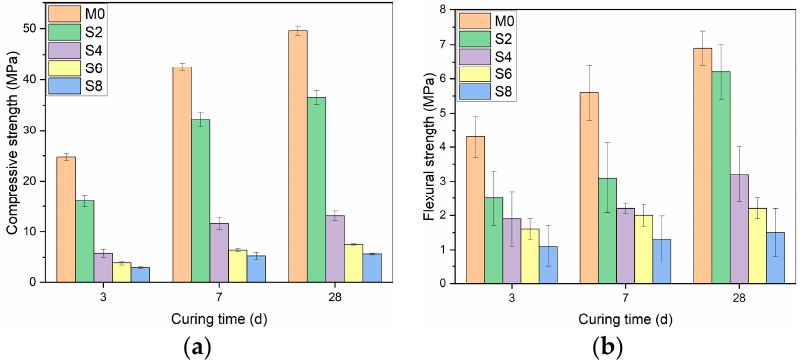
Figure 6. The e ff ect of sucrose on the compressive and fl exural strength of AAS under di ff erent dosages. ( a ) Uncon fi ned compressive strength; ( b ) fl exural strength. dosages. ( a ) Unconfined compressive strength; ( b ) flexural